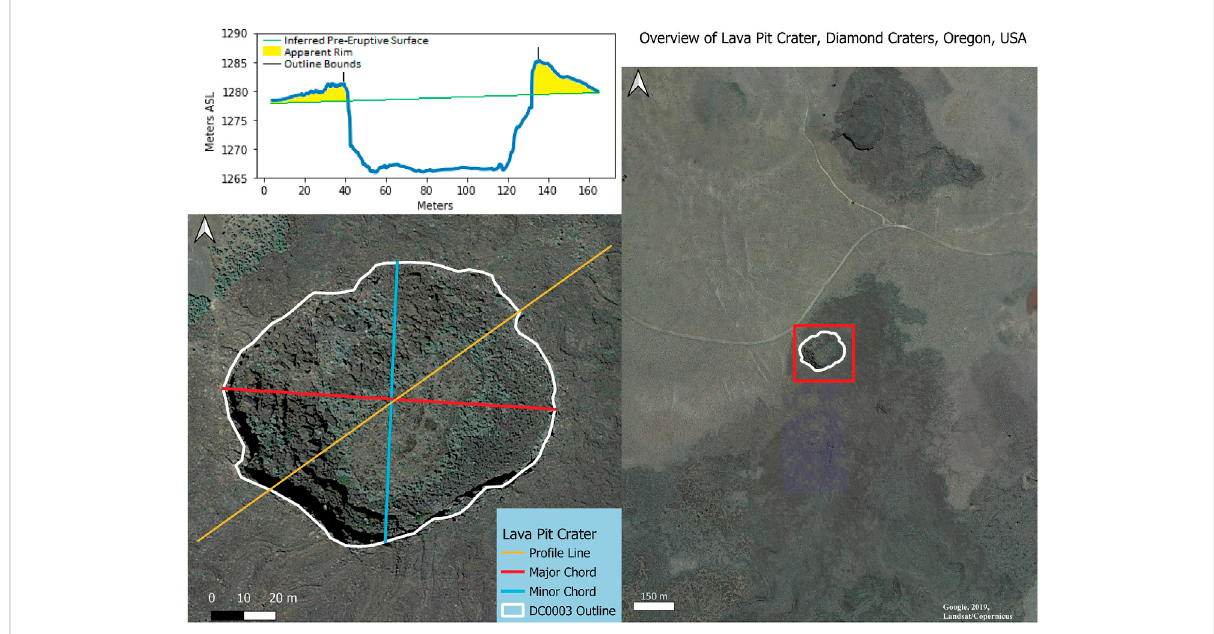
FIGURE 6 Extended topographic pro fi le of Lava Pit Crater, Oregon, United States . This example is unique because it has an apparent rim; the presence of therimalone isnot solely diagnostic. Lavapitcraterislinedwith blockycooledlava fragments. Theinteriorslopeangle is42.9 ° with sections closeto 90 ° . The bottom is fl at or saw-toothed. The saw-tooth of this bottom is caused by large blocky cooled lava fragments. Vertical exaggeration = 2.5x.